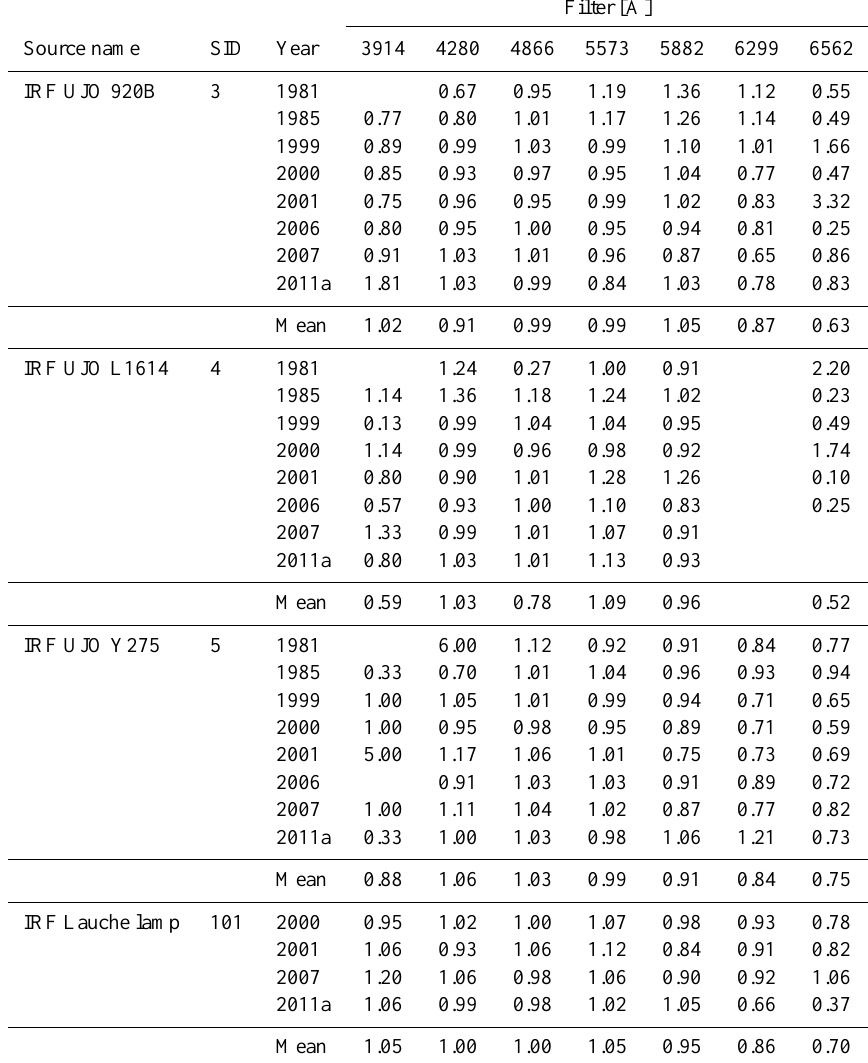
Table 3. Ratios of the 2011b intercalibration (Sodankyl¨a) to earlier intercalibrations and to the mean value of all listed measurements. Sources not appearing in this table lack information of earlier calibration workshops. SID is source identification